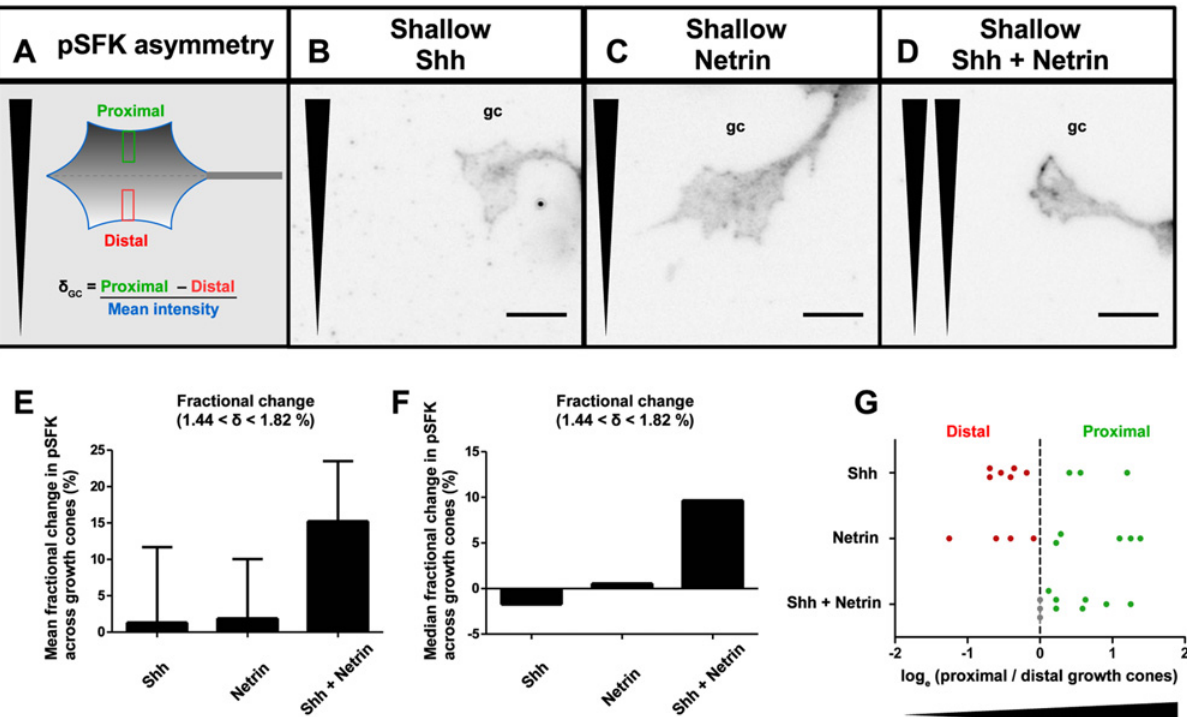
Fig 6. Combined shallow gradients of Shh and Netrin-1 synergize to polarize activated Src family kinase within the growth cone. (A) pSFK asymmetry across each growth cone was measured as the fractional change in pSFK fluorescence ( δ GC ). This was defined as the difference between mean intensities in the proximal third (green rectangle) and the distal third (red rectangle) of the mean intensity profile spanning the width of the growth cone, divided by the mean intensity of the entire growth cone area. Growth cones exposed to shallow, 1.44 < δ < 1.82% gradients of (B) Shh alone or (C) Netrin-1 alone do not show a directional bias in pSFK distribution after 2 h. However, (D) in the combined gradient, pSFK is asymmetrically localized to the proximal side of the growth cone (in this example, there is an 18% pSFK fractional change, similar to the mean fractional change that we observe in [ E ]). This results in a higher (E) mean and (F) median fractional change in pSFK across the growth cones. Polarized pSFK growth cone asymmetry was assessed by using a Wilcoxon signed-rank test against a hypothetical median of 0 (Shh: n = 99; Netrin: n = 107; Shh+Netrin: n = 126; p = 0.018 for Shh+Netrin). (G) The ratio of the number of growth cones with proximal versus distal pSFK asymmetry for each independent gradient device for 1.44 < δ < 1.82% demonstrates that while the devices with single cue gradients of Shh and Netrin alone have no bias for a proximal versus a distal distribution, those with combined gradients have consistently equal or more growth cones that are proximally rather than distally polarized ( p = 0.025, Chi-square analysis). Wedge represents direction of gradient ( A – D,G ). Scale bar ( B-D) : 10 μ m. Error bars represent